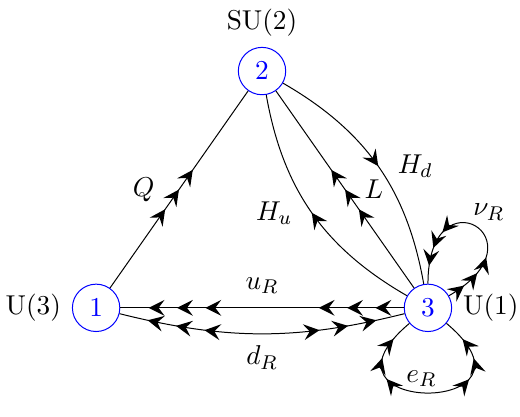
Figure 1 . Standard Model quiver containing an additional U(1) B . The right-handed neutrinos transform in the (trivial) adjoint of U(1) and are thus uncharged under all gauge group